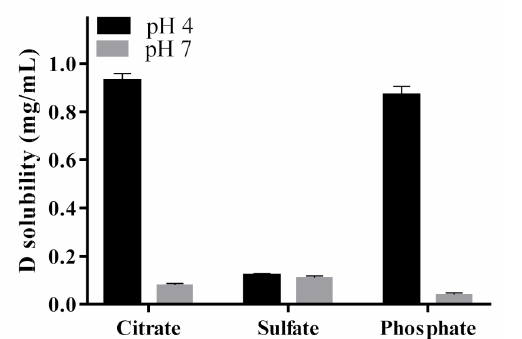
Figure 1. Solubility of doxorubicin (D) in different salt solutions as a function of